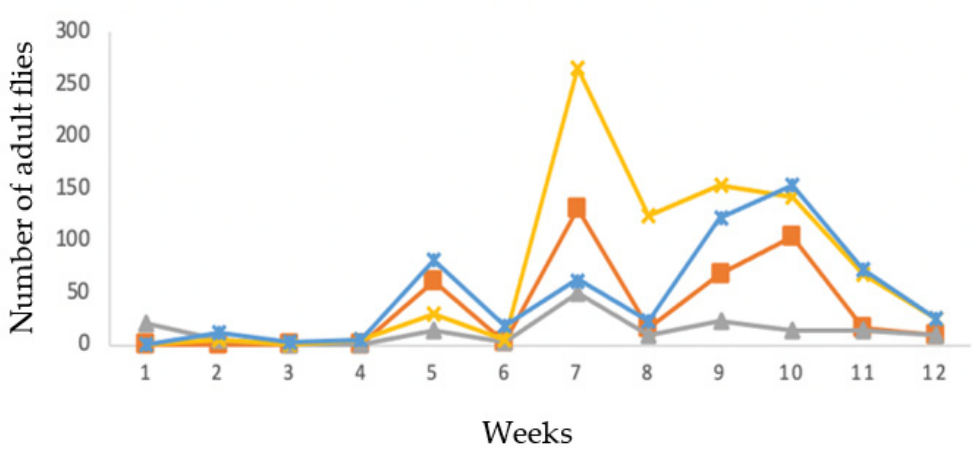
Figure 5. Effects of three mulching practices in comparison to unmulched control on the capture of D. suzukii in blueberry field using Scentry ® trap in 2017.